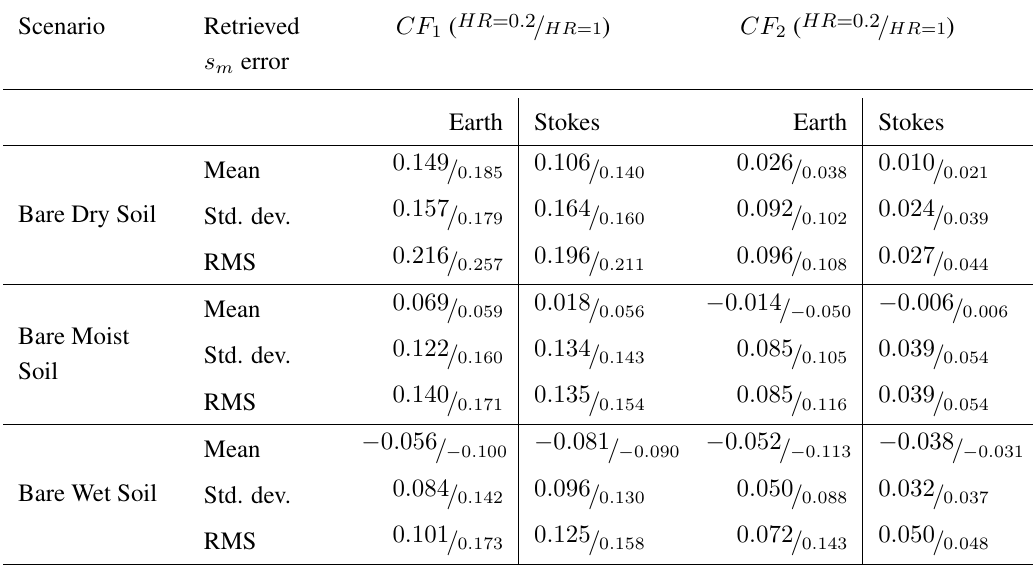
Table 3. Retrieved mean, standard deviation and root mean square soil moisture error of simulated SMOS observations over the bare soil scenarios on Table 1, using the cost function configurations of Table 2, formulated on the Earth reference frame or using the first Stokes parameter.